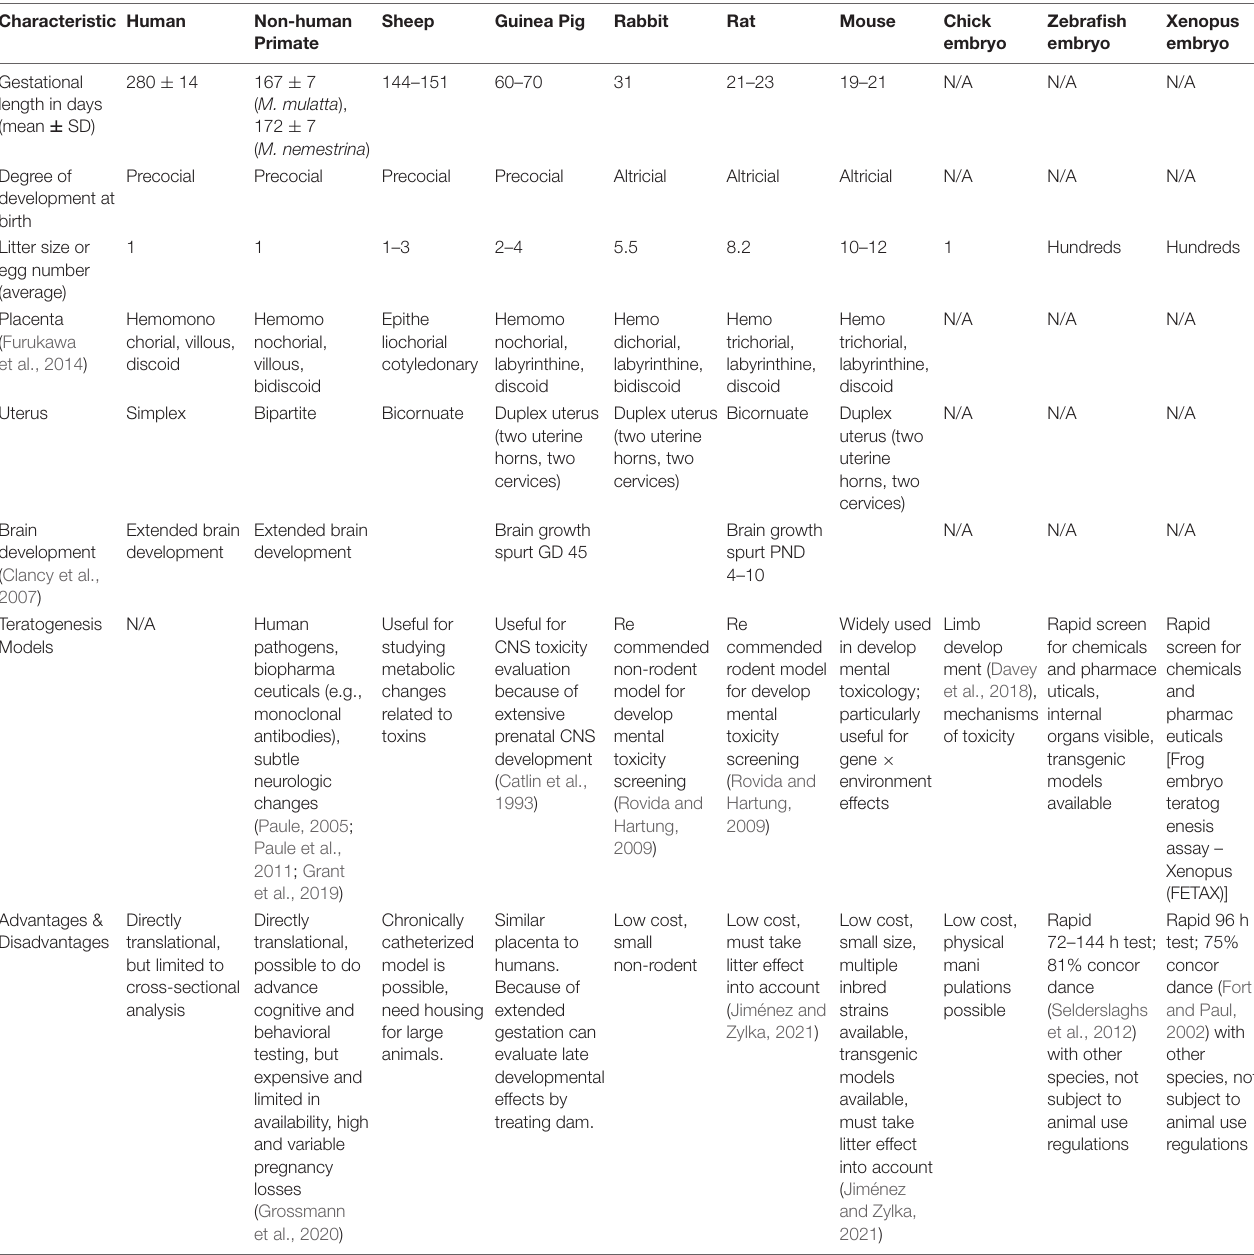
TABLE 1 | Comparison of animal models for investigation of